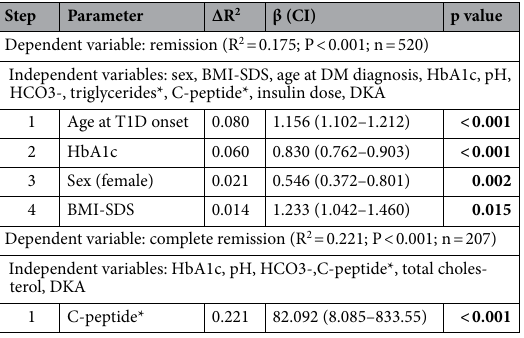
Table 2. Logistic regression of remission, and complete remission as dependent variables. Analyzed in forward logistic multiple regression analyses. DM diabetes mellitus, BMI body mass index, SDS standard deviation score, DKA diabetic ketoacidosis. Significant values are given in bold. *Calculated with log transformed data.